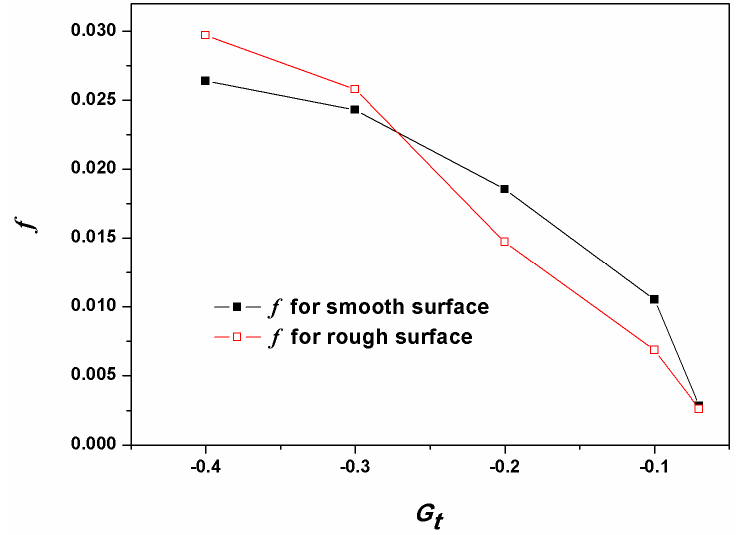
Figure 14. Frictional resistance coefficient of channel flow for smooth and rough surfaces ( 6.0  G